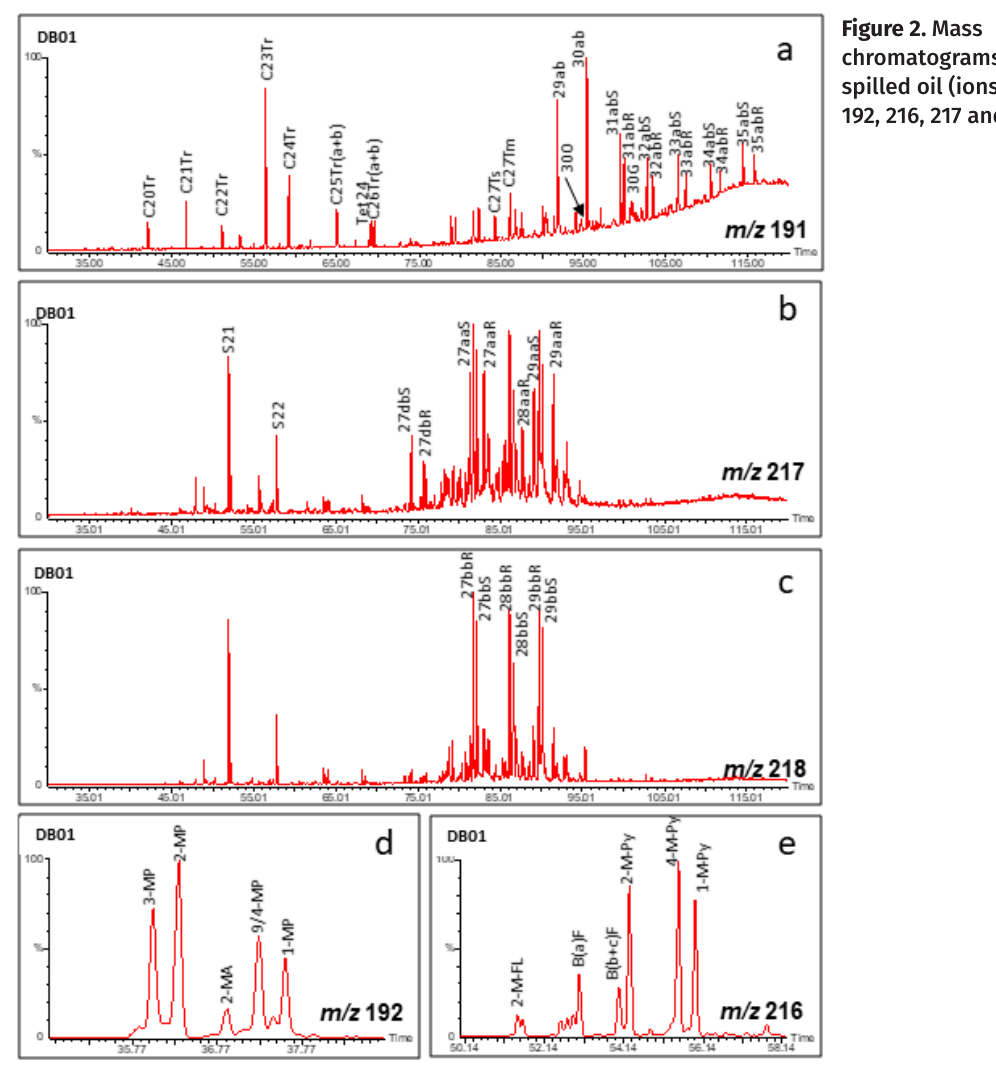
Figure 2. Mass chromatograms of the spilled oil (ions m/z 191, 192, 216, 217 and